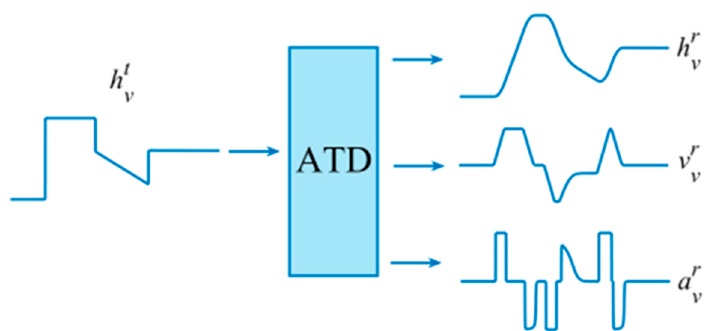
Figure 8. Diagram of reference trajectory generated from waypoint information.